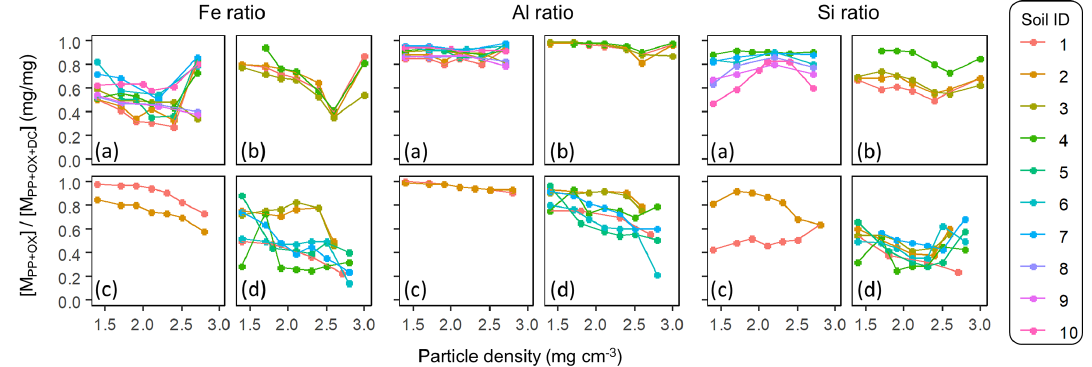
Figure A4. Proportion of total extractable Fe (left), Al (center), and Si (right panels) present as pyrophosphate- plus oxalate-extractable phases. This ratio obtained from each density fraction was shown along the density gradient for allophanic Andisols (a) , non-allophanic Andisols (b) , Spodosols (c) , and crystalline mineralogy group (d) . Each symbol represents the individual soil sample ID in Table